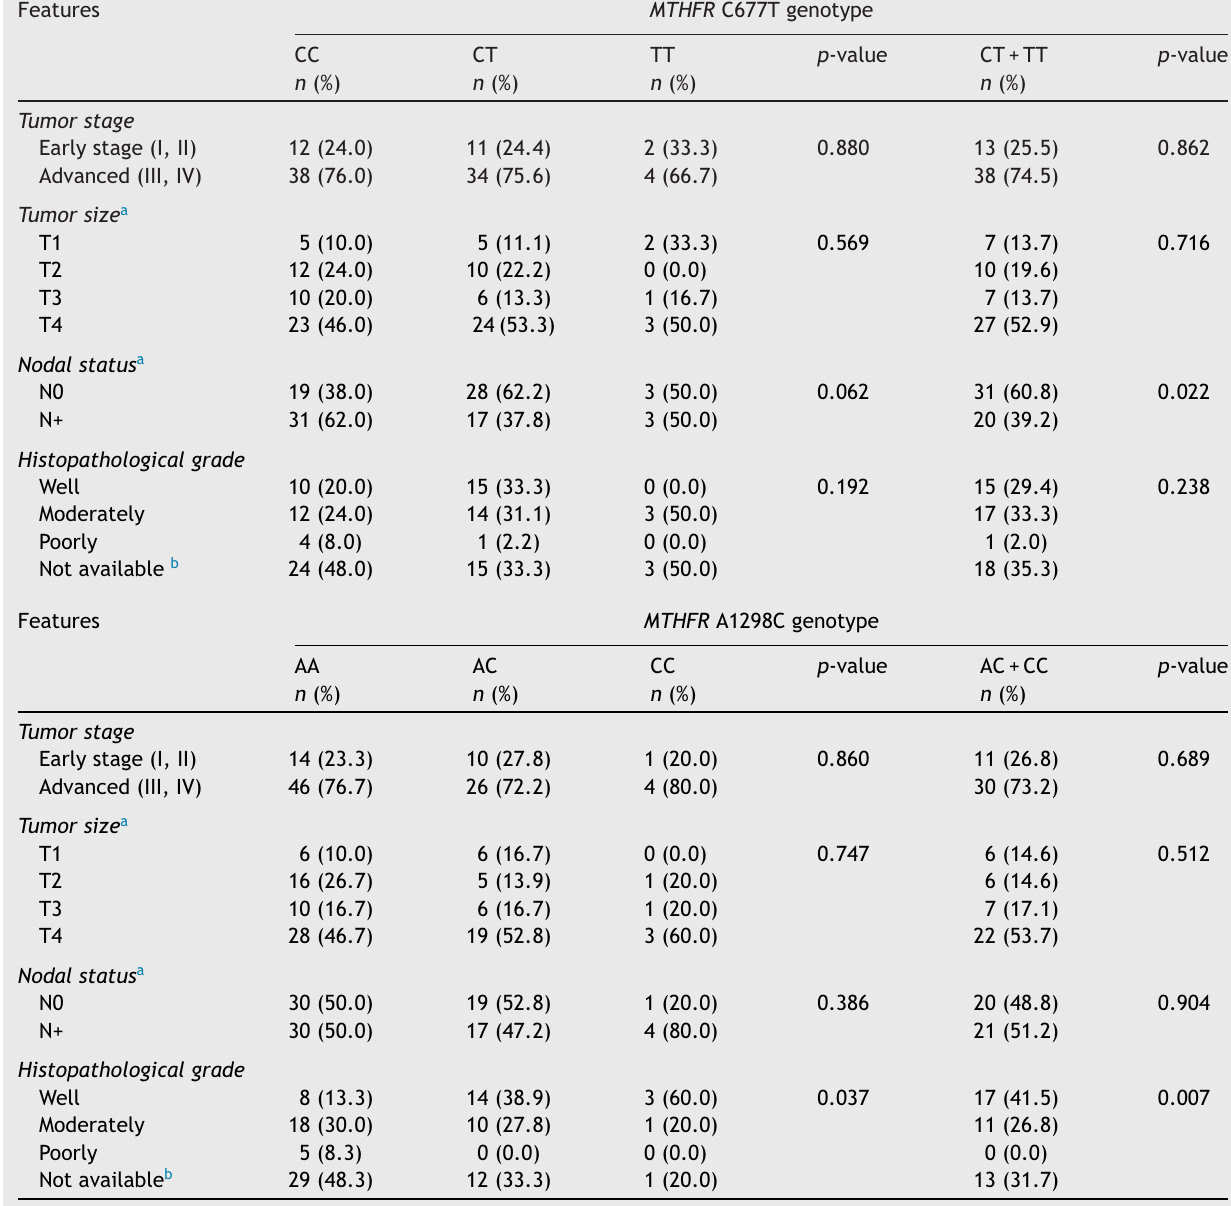
Clinicopathological characteristics of patients with OSCC and relation with the MTHFR polymorphisms